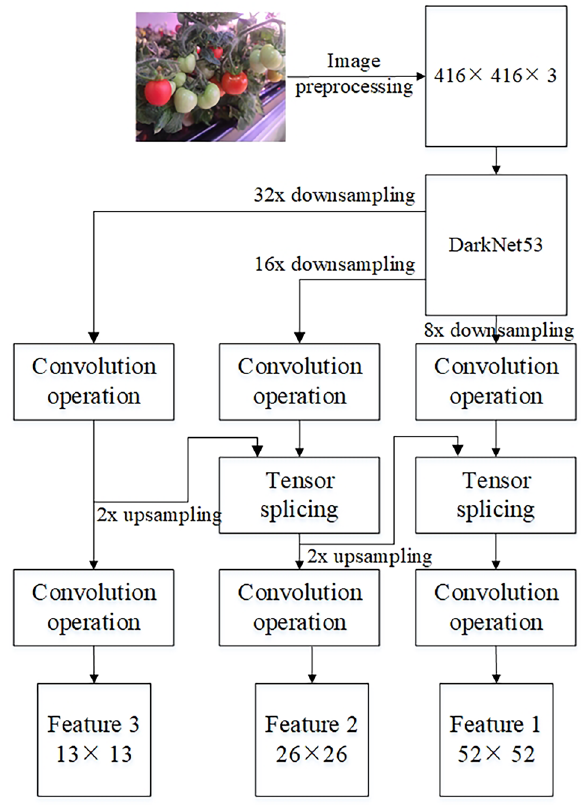
Figure 5. Principle of DarkNet53 Multi-scale feature extraction.